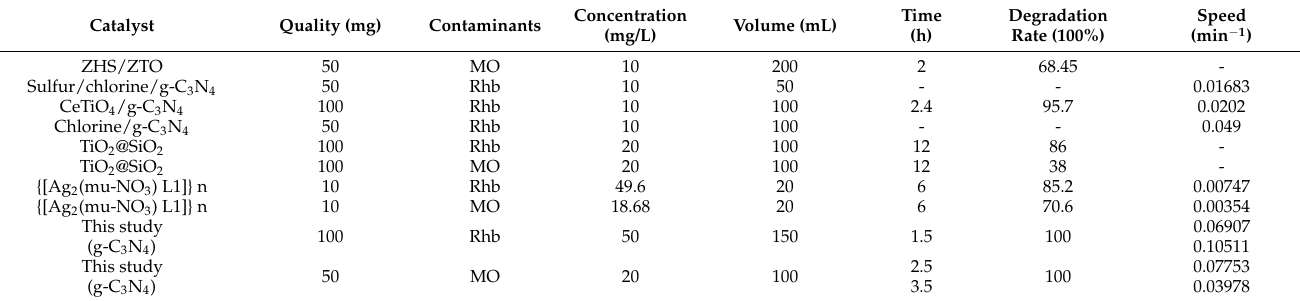
Table 3. Comparison of the various parameters of dye